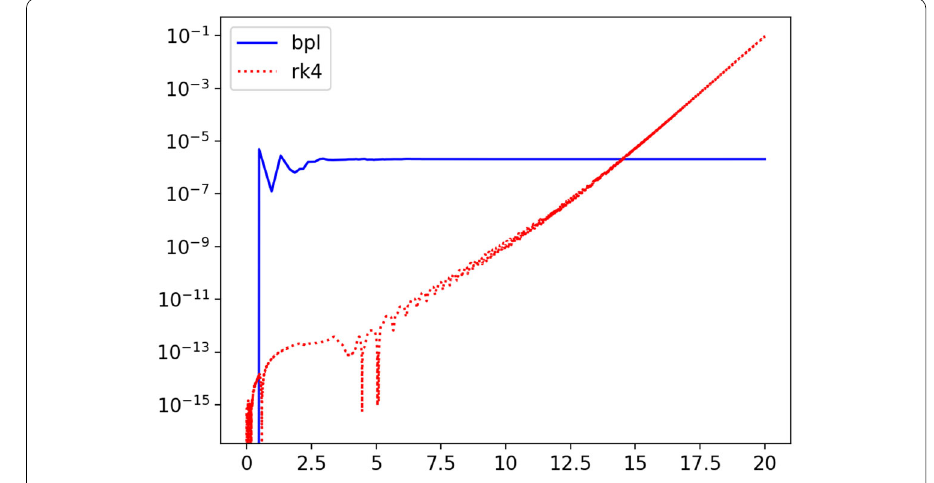
Fig. 12 Duffing equation, Case1 . Relative error on first integral (36)